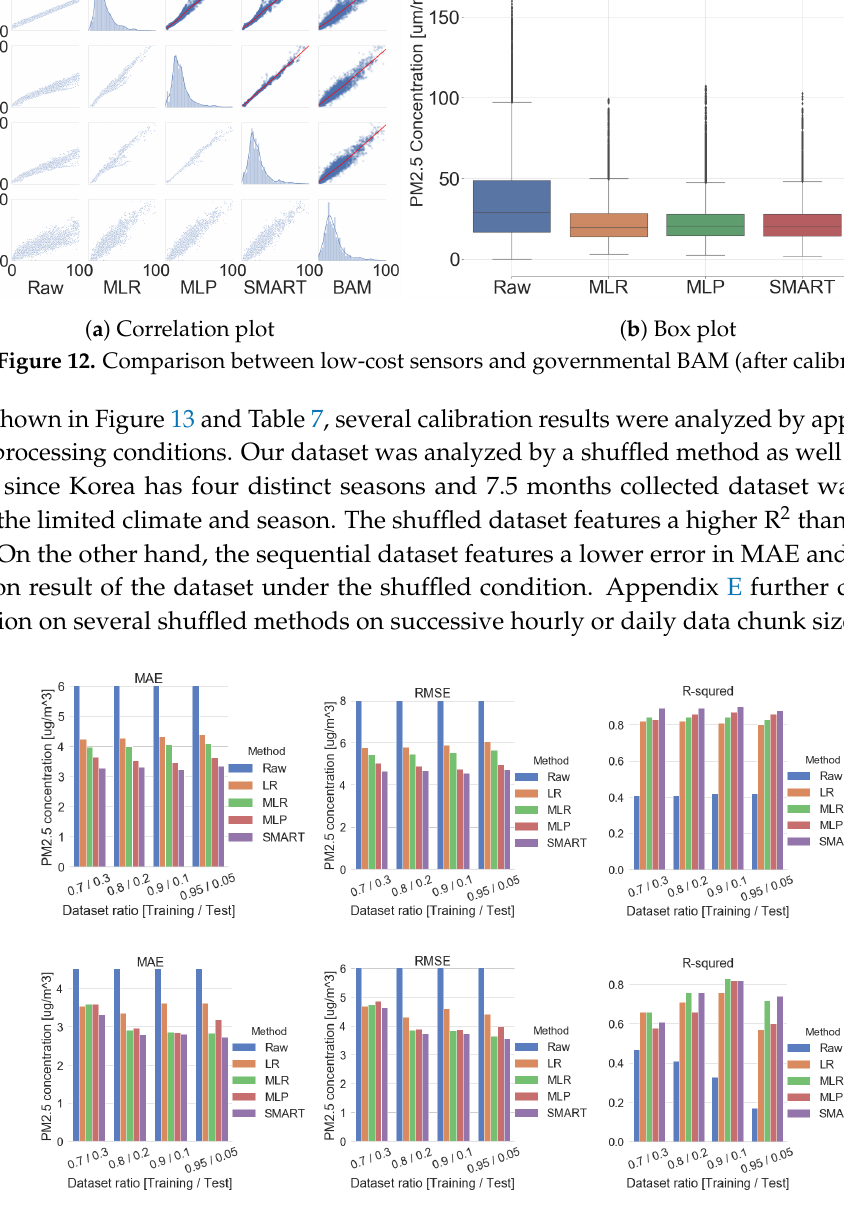
Figure 13. Comparison plot by data preprocessing methods—shuffled ( top ) and sequential ( bottom